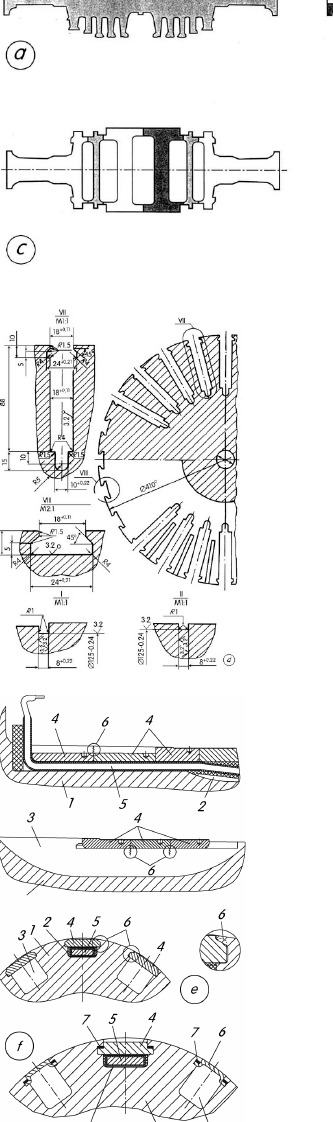
Figure 3. Types of turbine rotor construction: ( a )—schematic of a monoblock stream turbine rotor, ( b1 , b2 )—schematic of a built-up stream turbine rotor with shrunk-on discs; ( c )—schematic of a welded stream turbine rotor. The welds connect the discs (ABB Power Generation, Baden, Switzerland) [2,9–23]. Rotor body with detailed drawing of gaps for wedges and winding ( d ) [5]. Linear slots of the hydrogen cooled turbogenerator rotor shaft tail (original design). 1 —rotor shaft; 2 —current supply slot; 3 —ventilation slot; 4 —slot wedges; 5 —current supply tire; 6 —shaft fracture areas due to fretting (wedge joining areas) ( e ). Design slot wedges rotor tail after application of the antifretting measures system: 1 —rotor shaft; 2 —current supply slot; 3 —ventilation slot; 4 —current supply wedge; 5 —current supply tire; 6 —ventilation slot wedge; 7 —easy shifting seal ( f )